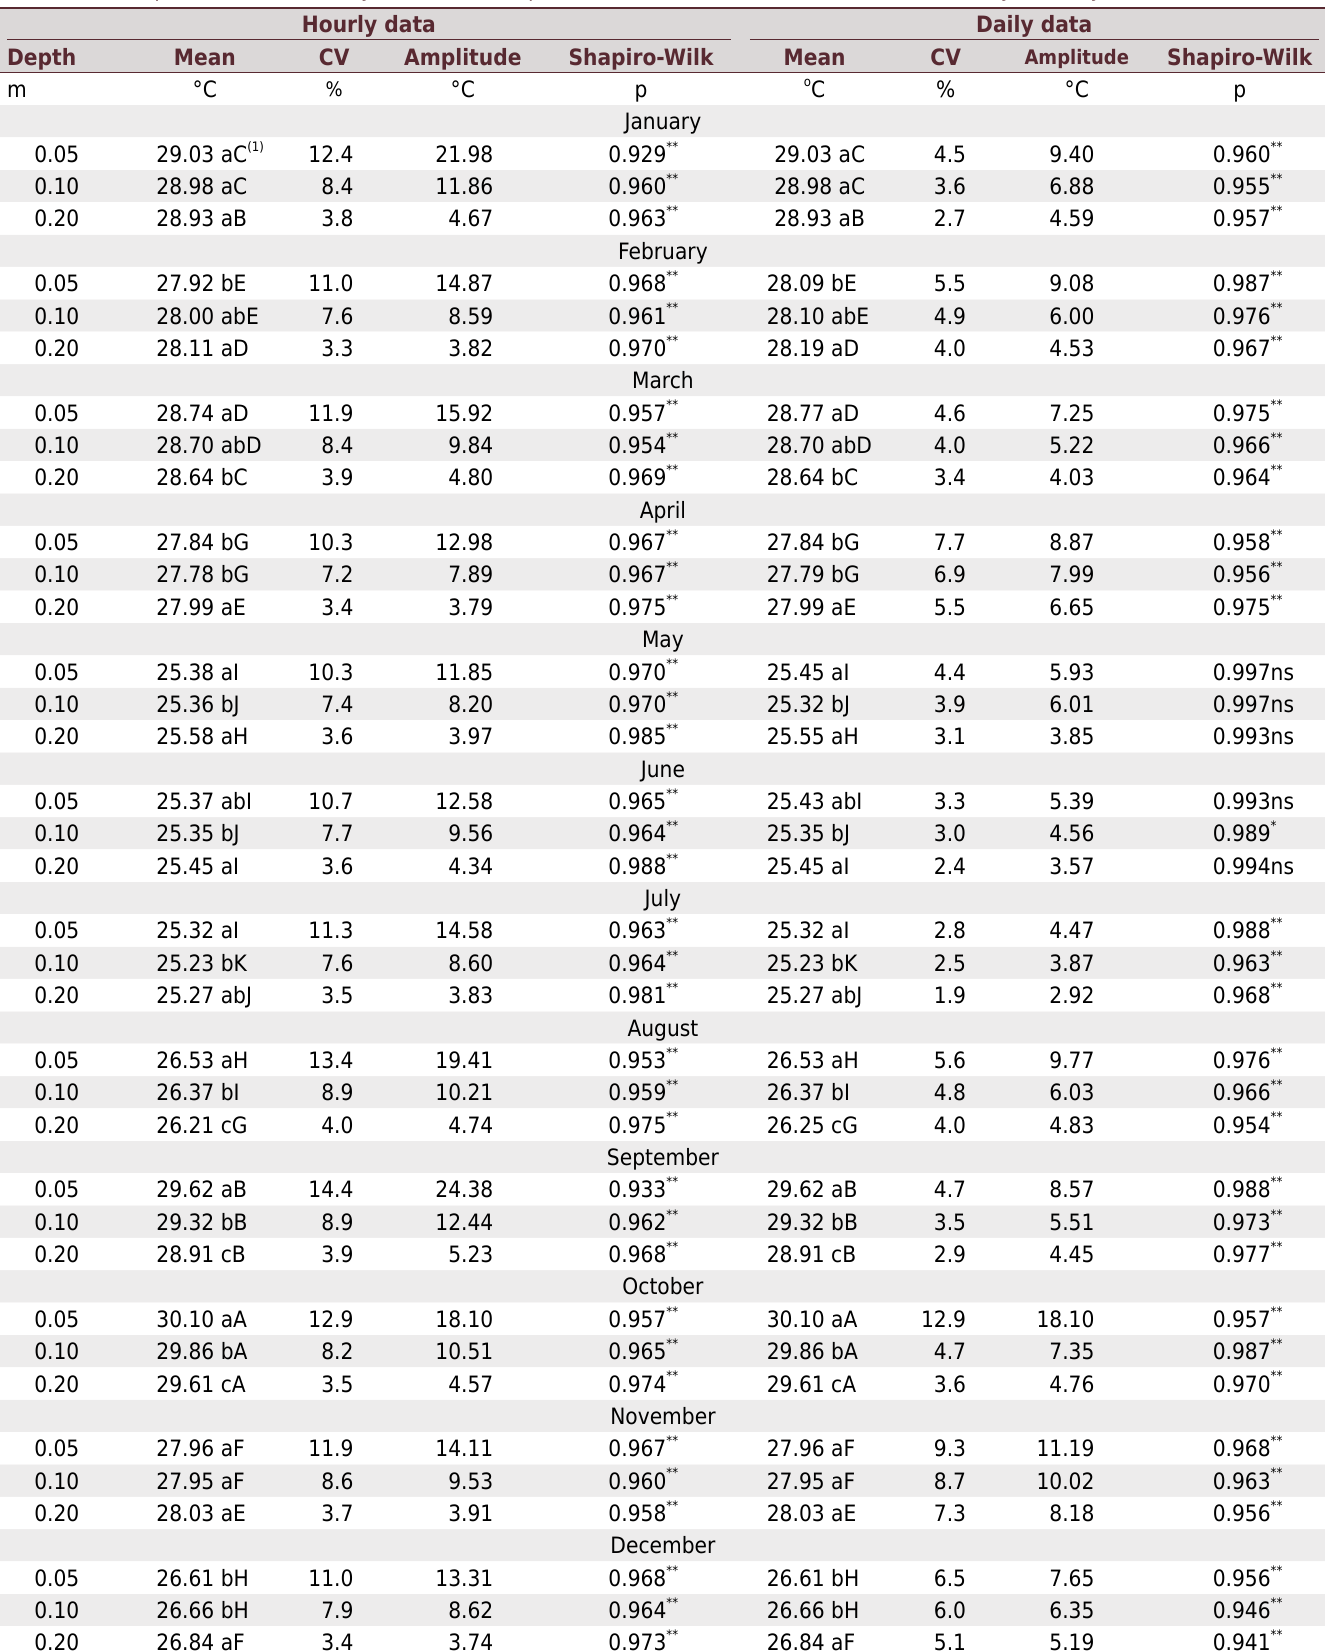
Table 3. Statistical summary of monthly, hourly, and daily soil temperature at different depths of a Cambissolo Háplico Ta Eutrófico (Cambisol; Inceptisol), from February 04, 2014 to September 30, 2015, in São Gabriel, Irecê Identity Territory, Bahia, Brazil Hourly data Daily data Depth Amplitude Shapiro-Wilk Mean CV Amplitude